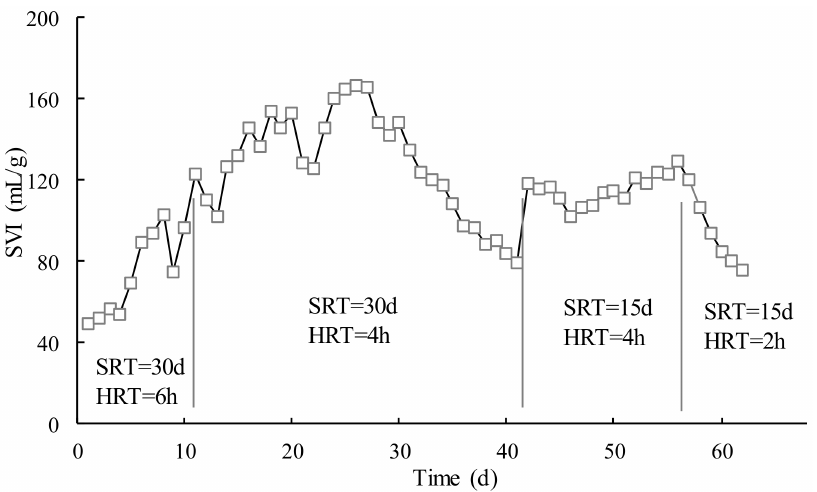
Figure 2. Effect of SRT and HRT on sludge